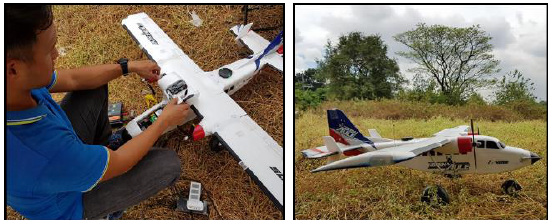
Figure 8. Lightweight fixed-wing UAV owned by Sir Patrick Ostrea (Photos taken during fieldwork)